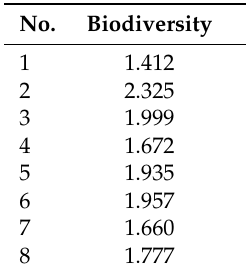
Table 2. Biodiversity change during the study.